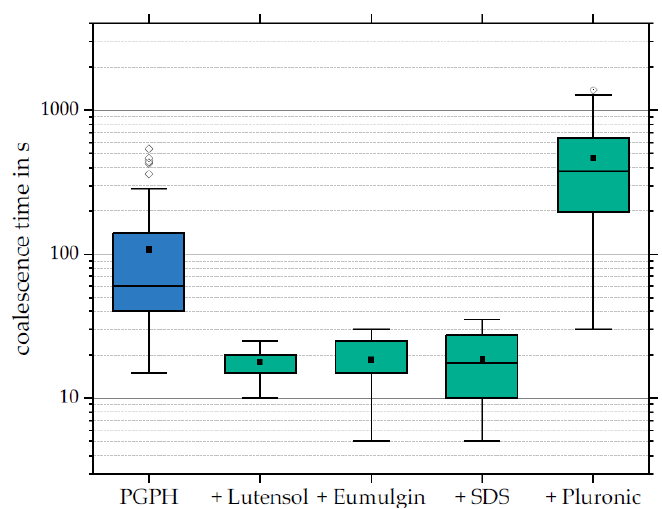
Figure 5. Coalescence time of water droplets stabilized with 0.1 wt% PGPH and additional 0.1 wt% of the four different hydrophilic surfactants. Boxplot symbols as described in Figure